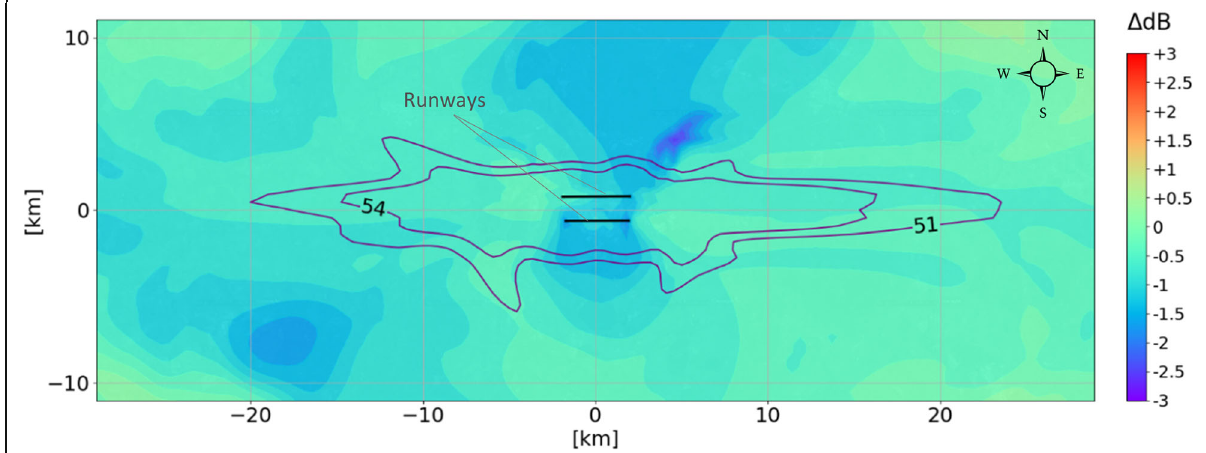
Fig. 2 Map of predicted variations in L Aeq,day at Heathrow Airport from 2018 to 2025 due to fleet substitution ( Δ dB = L Aeq,day,2025 - L Aeq,day,2018 ). 51-dB and 54-dB L Aeq,day contour lines computed for 2018 are